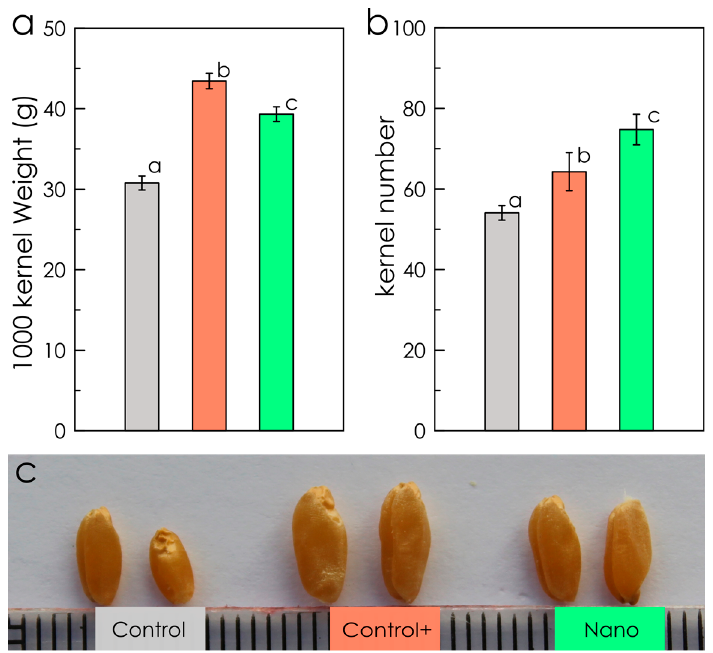
Figure 4. Yield parameters of durum wheat. Average thousand-kernel weight ( a ) and total kernel number ( b ) per plant. Data are expressed as average with the corresponding standard error as bars ( n = 3). Different letters indicate significant differences between the treatments ( p ≤ 0.05). Representative picture showing the kernel size of the different treatments ( c ).